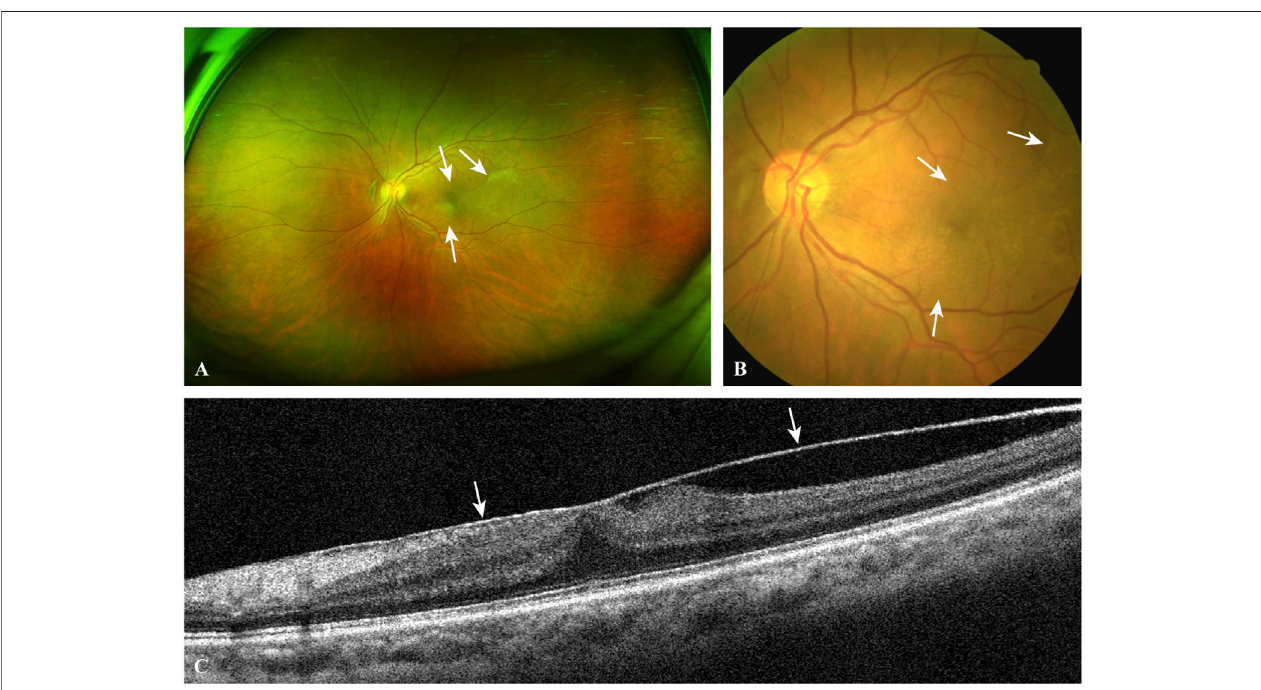
FIGURE2| AtypicalcaseofEMM.Theultra-wide fi eldretinalimage (A) andthefundusphotograph (B) showmacularpuckers(whitearrows)causedbycontracted EMMs. OCT scan (C) through the central fovea of (A,B) demonstrates a contracted EMM (white arrows) causing signi fi cant macular wrinkling and thickening. EMM, epimacular membrane; OCT, optical coherence